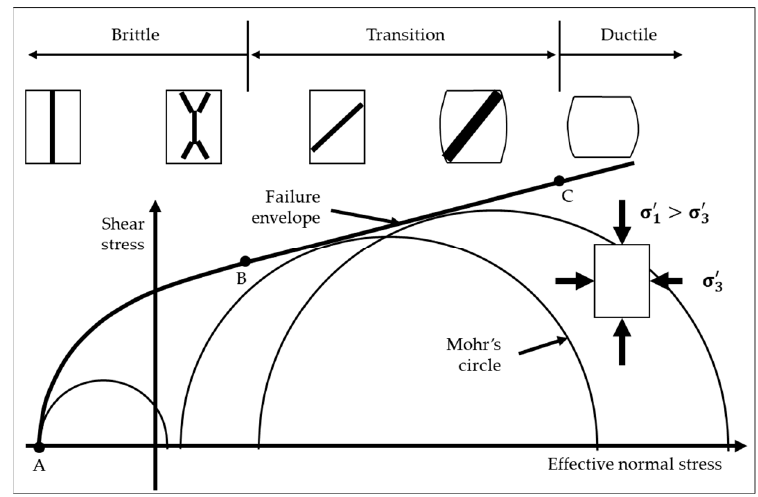
Figure 1. The possible modes of failure or fractures based on the mechanical behavior of the caprock are illustrated in the Mohr–Coulomb failure envelope (modified after Nygård et al. [28]). The points A, B, and C on top of the failure envelope define the brittle, transition, and ductile zones of any caprock.